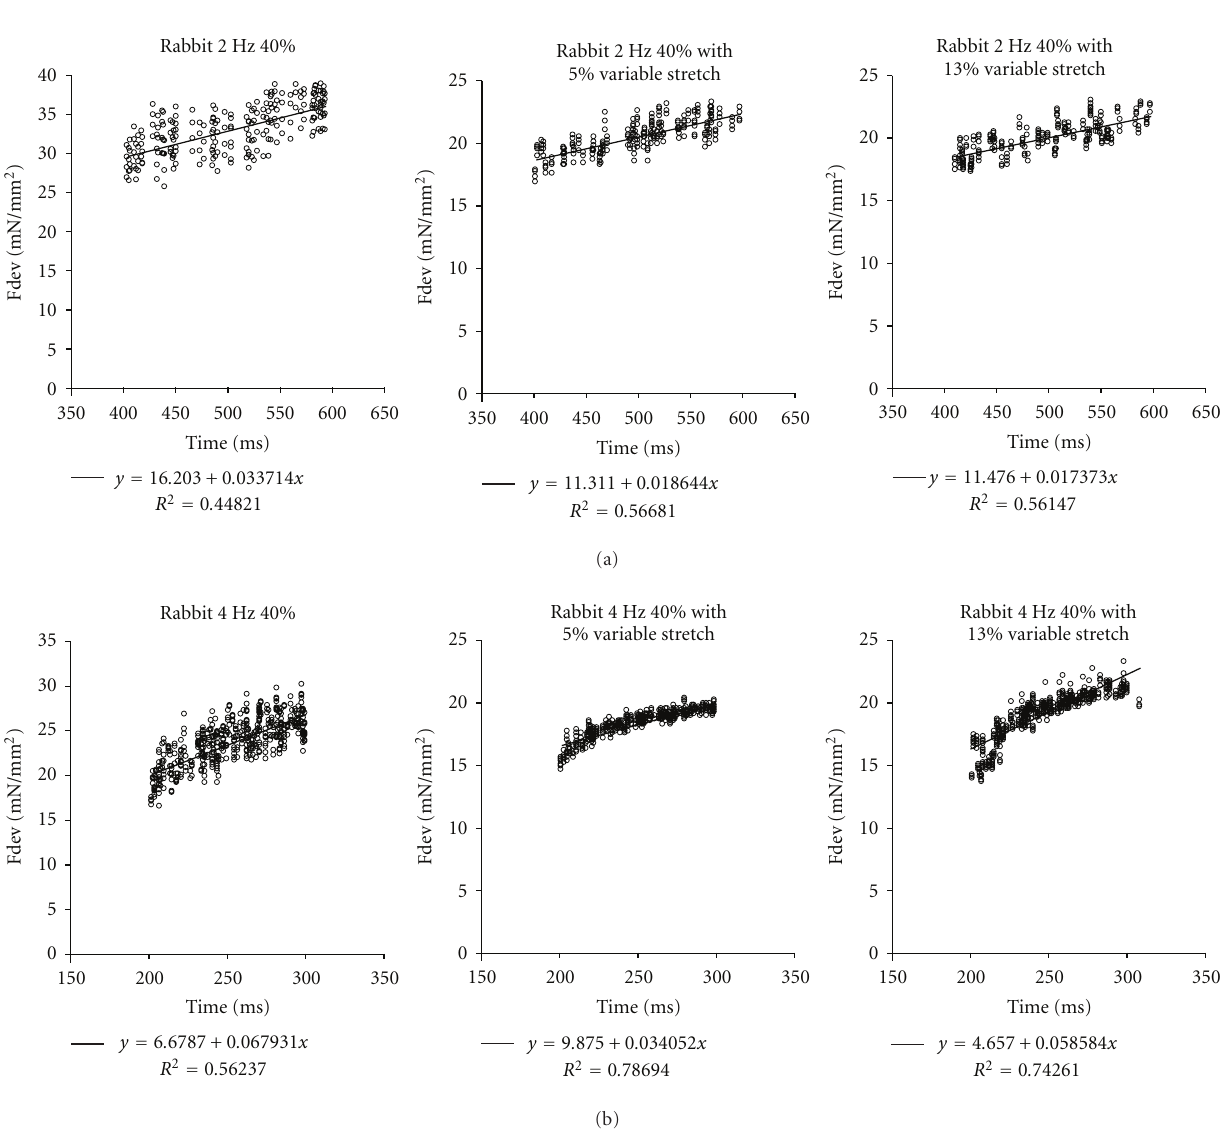
Figure 5: Top half displays the interaction between prebeat duration and force development at 2Hz. The correlation coe ffi cients are increasingly tighter as the preload stretch is increasingly applied. On the bottom half, we depict the same phenomena at the higher frequency (4Hz). The correlation here is more evident and significantly di ff erent statistically ( P < 0 . 01) from the initial nonstretch correlation value of